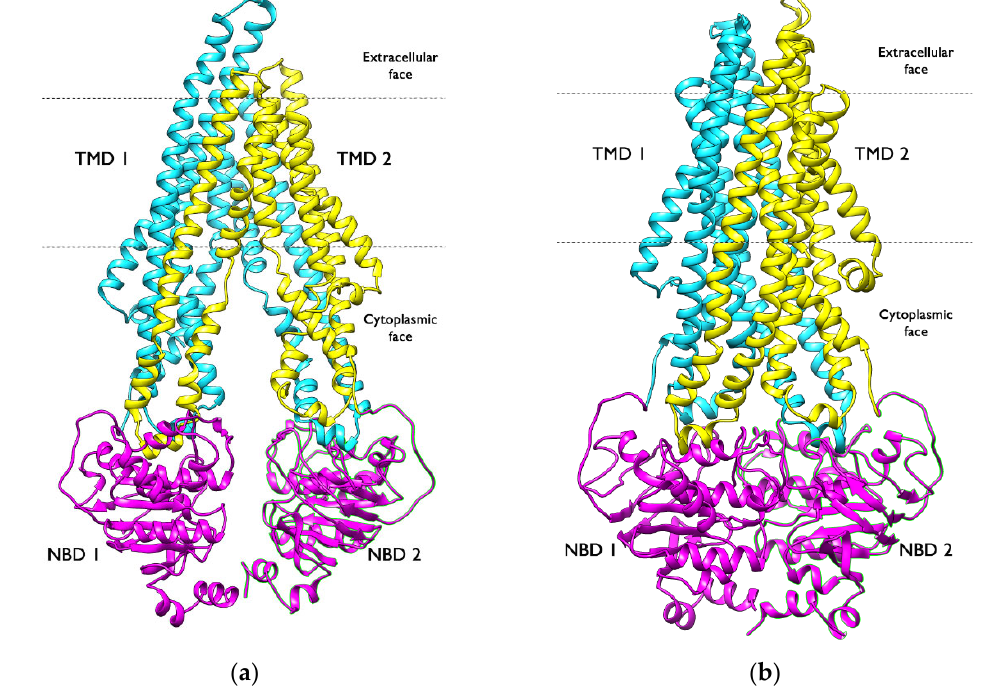
Figure 1. Cryo EM structures of h P gp. ( a ) Inward-facing conformation (PDB ID: 6QEX); ( b ) outward-facing conformation (PDB ID: 6C0V). Nucleotide binding domains (NBDs) are shown in magenta, and transmembrane domains (TMDs) are shown in cyan and yellow.